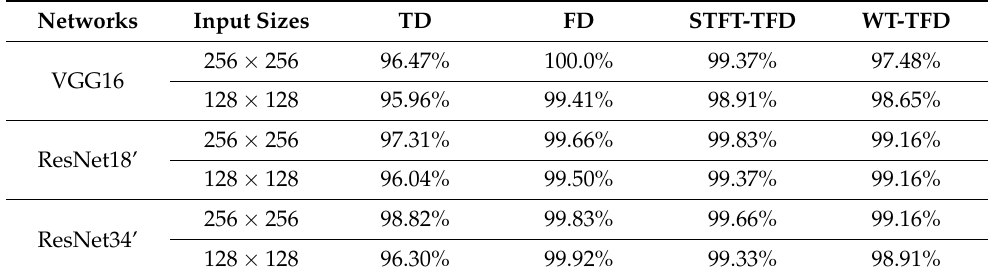
Table 6. Test accuracies of 22%SEU.